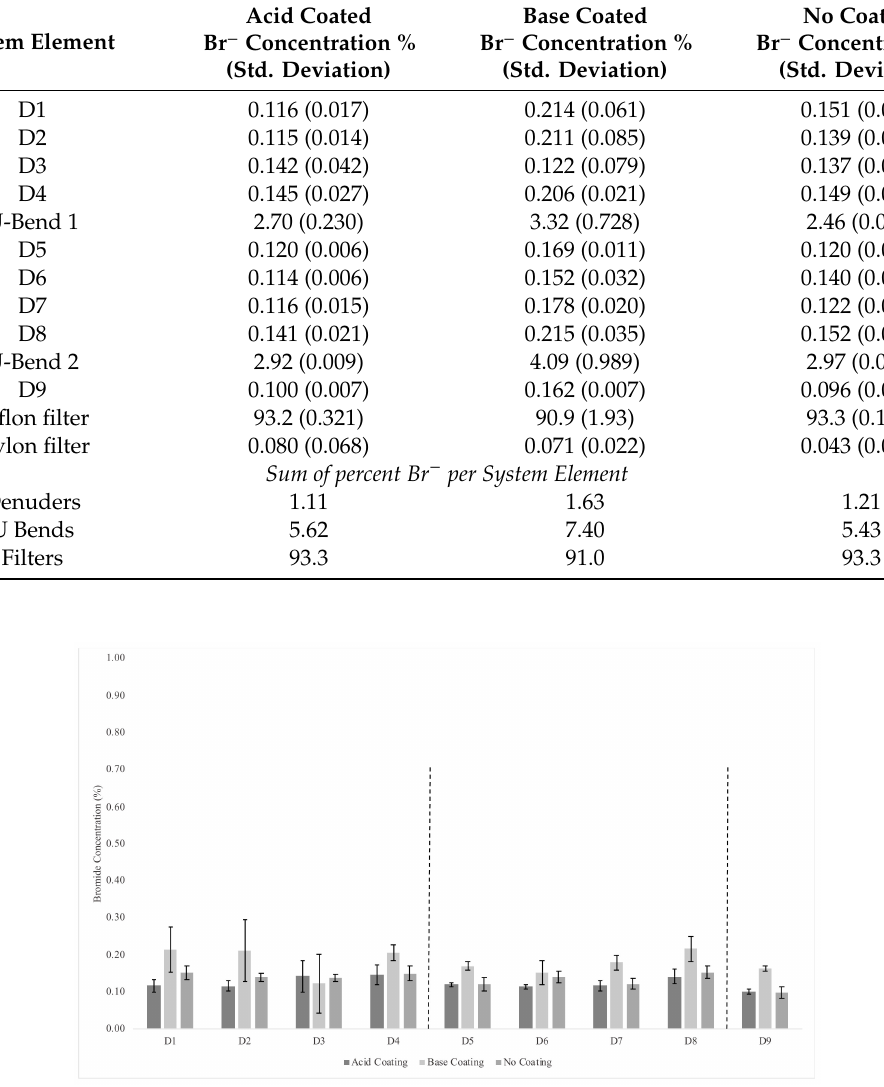
Figure 7. Br − aerosol concentration on the denuder walls for the 9-ADS set-up. The values are given as the average percentage of the three trials conducted per coating type (acid, base, or no coating) for a total of nine